Question: What does this figure show? Answer in one sentence.
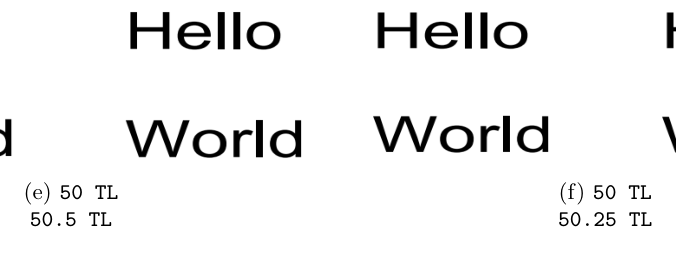
Answer: Tl Operator - control, 10%, 5%, 2%, 1%, 0.5% (2%)